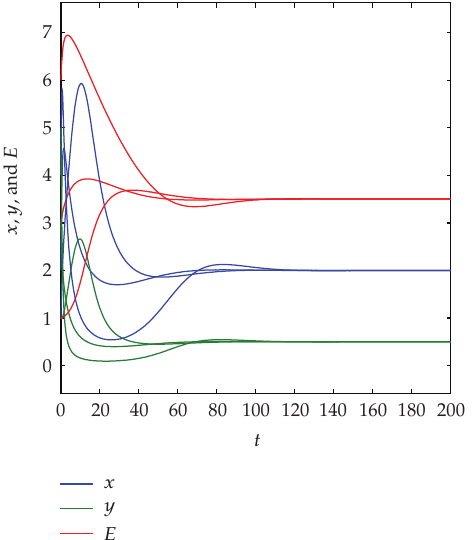
Figure 5: Solution curves of system (cid:6) 4.1 (cid:7) with the parameters given by Example 6.2 when r 1 (cid:8) 0.